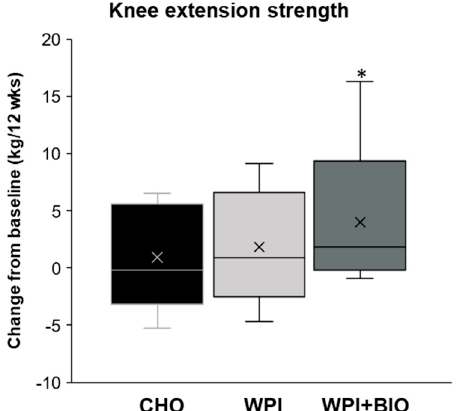
Figure 3. Change from baseline for muscle knee extension strength in elderly subjects with limited mobility treated with a combination of EMS and nutritional supplement: CHO, WPI or WPI + BIO for 12 weeks. In the box plots, the boundary of the box closest to zero indicates the 25th percentile, a line within the box marks the median, a cross within the box marks the mean, and the boundary of the box farthest from zero indicates the 75th percentile. Whiskers above and below the box indicate the 10th and 90th percentiles. ( n = 10–15). * significantly di ff erent from CHO, p < 0.05 (linear mixed